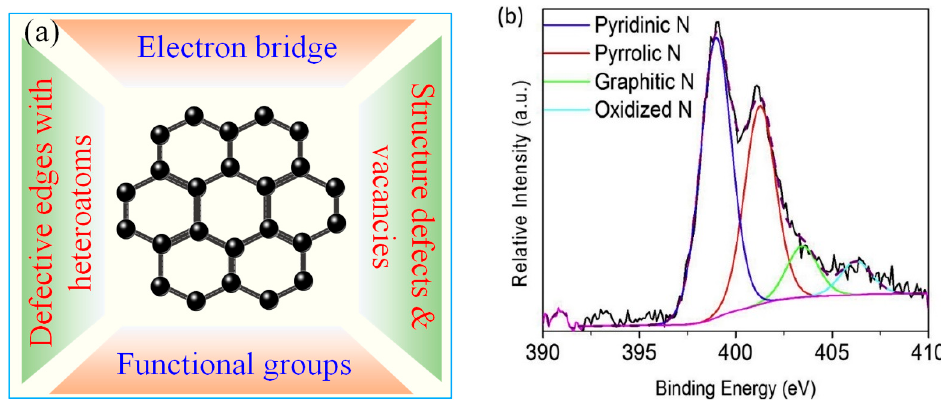
Figure 3. ( a ) The proposed active sites of MFCMs for 1 O 2 evolution via catalytic PDS/PMS activation. ( b ) The XPS spectra of N 1s for doping N element in different states [67], reprinted with permission from Elsevier .